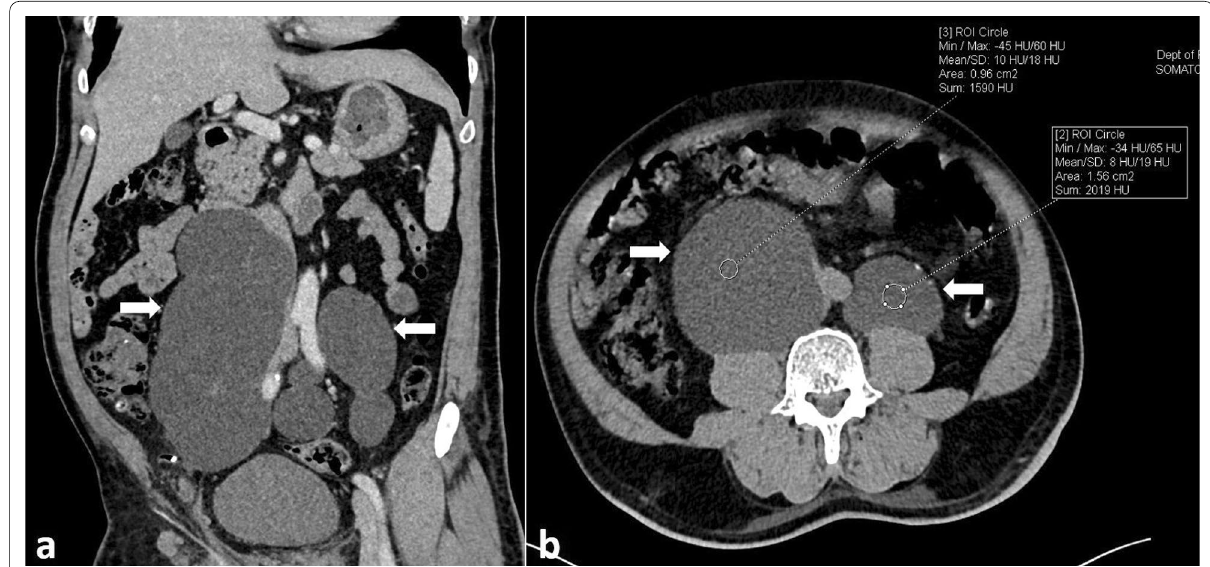
Fig. 1 CT coronal ( a ) and axial ( b ) images showing thin walled cystic masses (white arrows) in retroperitoneum with mean Hounsfield Unit value of